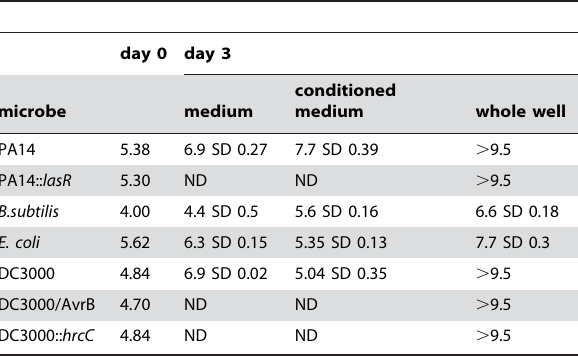
Table 1. Growth of different microbes in the plant growth medium and in the presence of